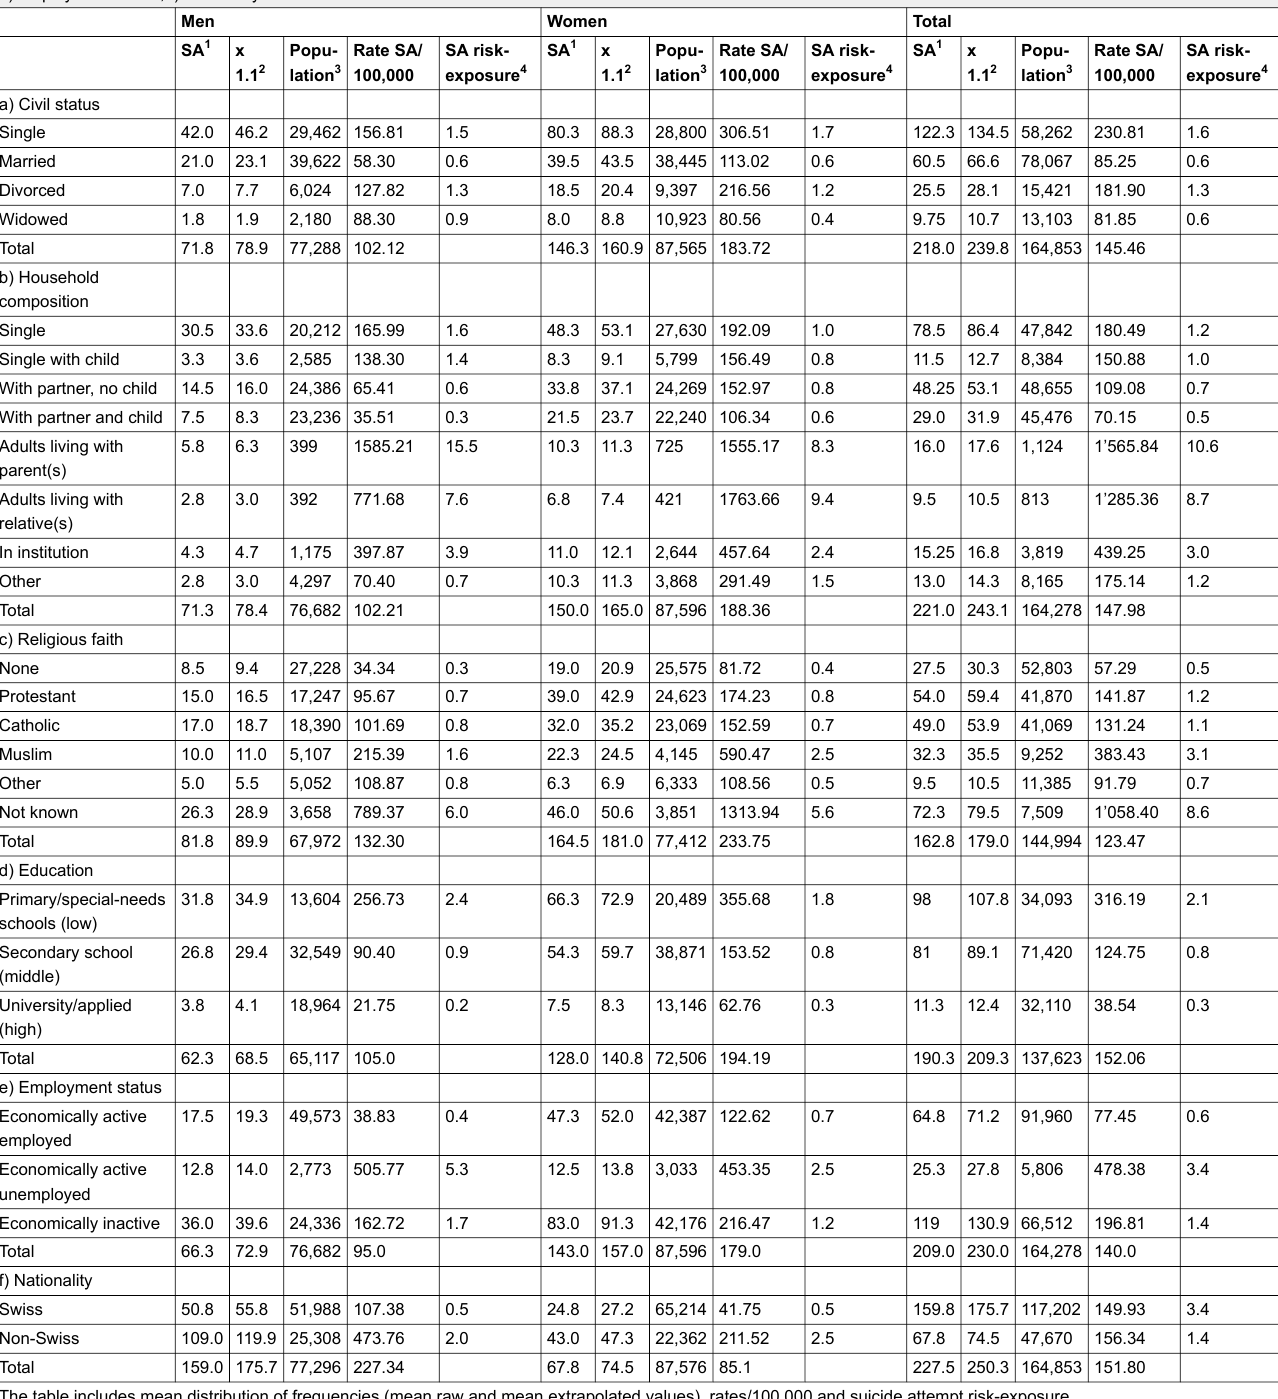
Table 3: Suicide attempt rates in the county of Basel-City, 2003 to 2006, according to gender for a) civil status, b) household composition, c) religious faith, d) education, e) employment status, f) nationality.